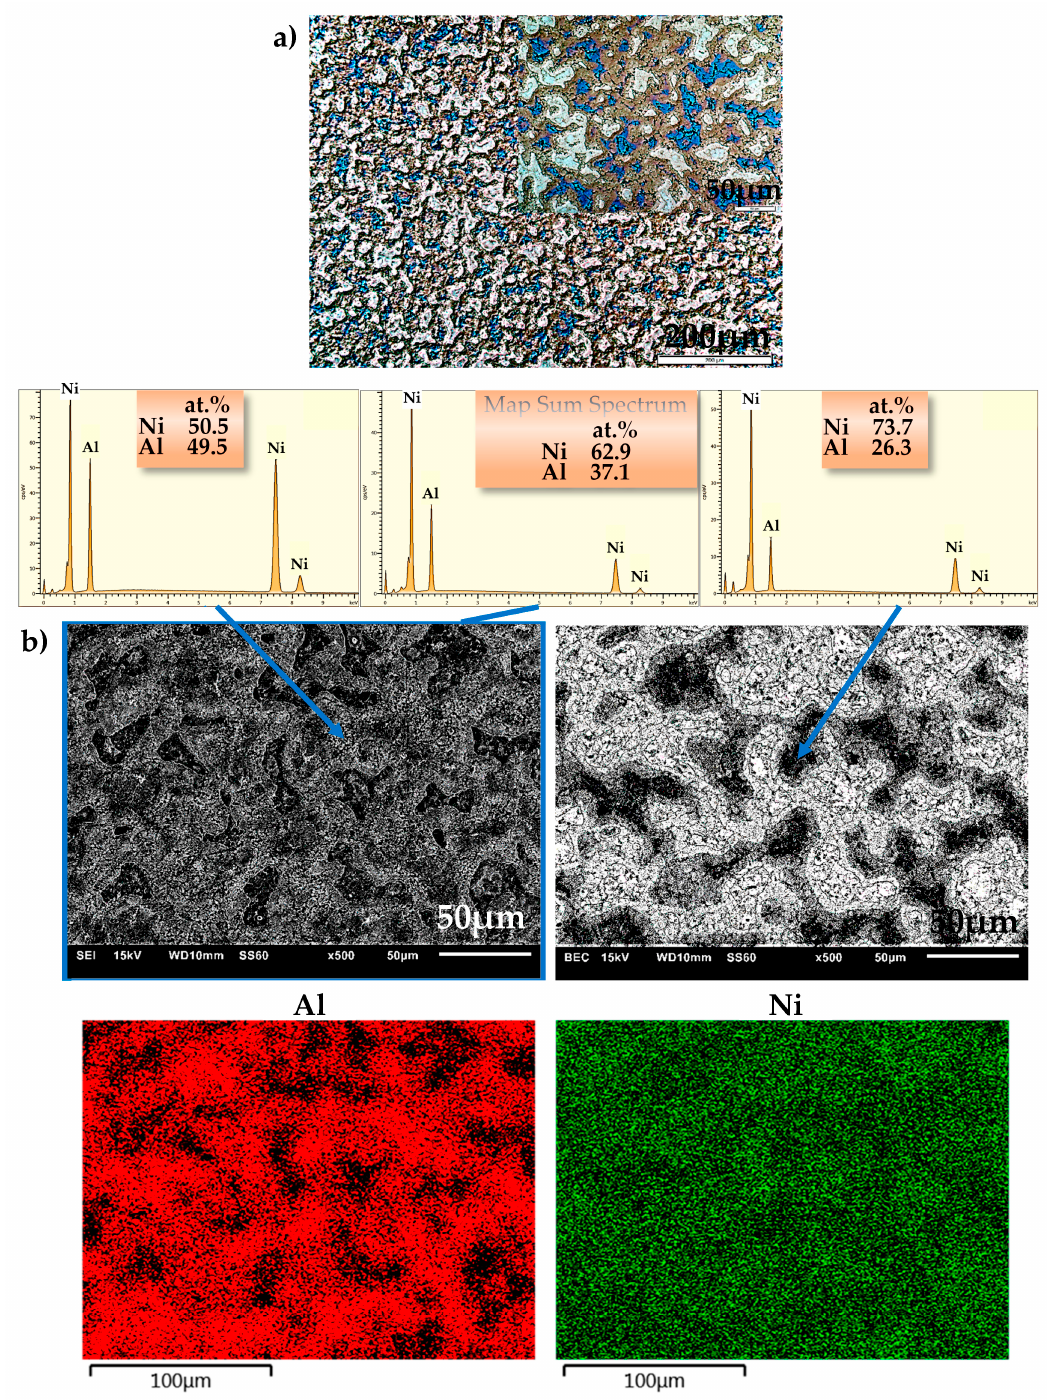
Figure 4. Microstructure of NiAl37 alloy: ( a ) optical microscope, Nomarski contrast; ( b ) SEI—secondary electron image—( left ) and BEC—backscattered electron composition—( right ) SEM micrograph, point-and-map analysis of the distribution of individual microstructural constituents.